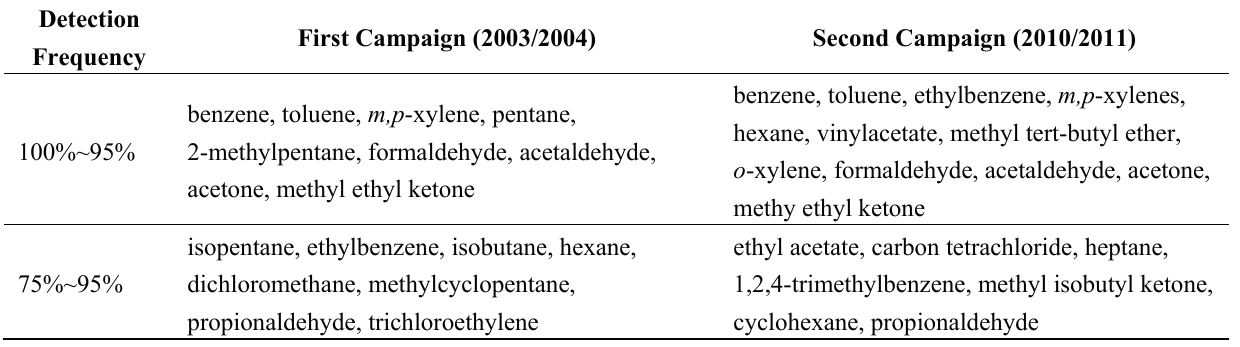
Table 2. Frequencies of detection for the target VOCs in the ambient air of Gumi city.